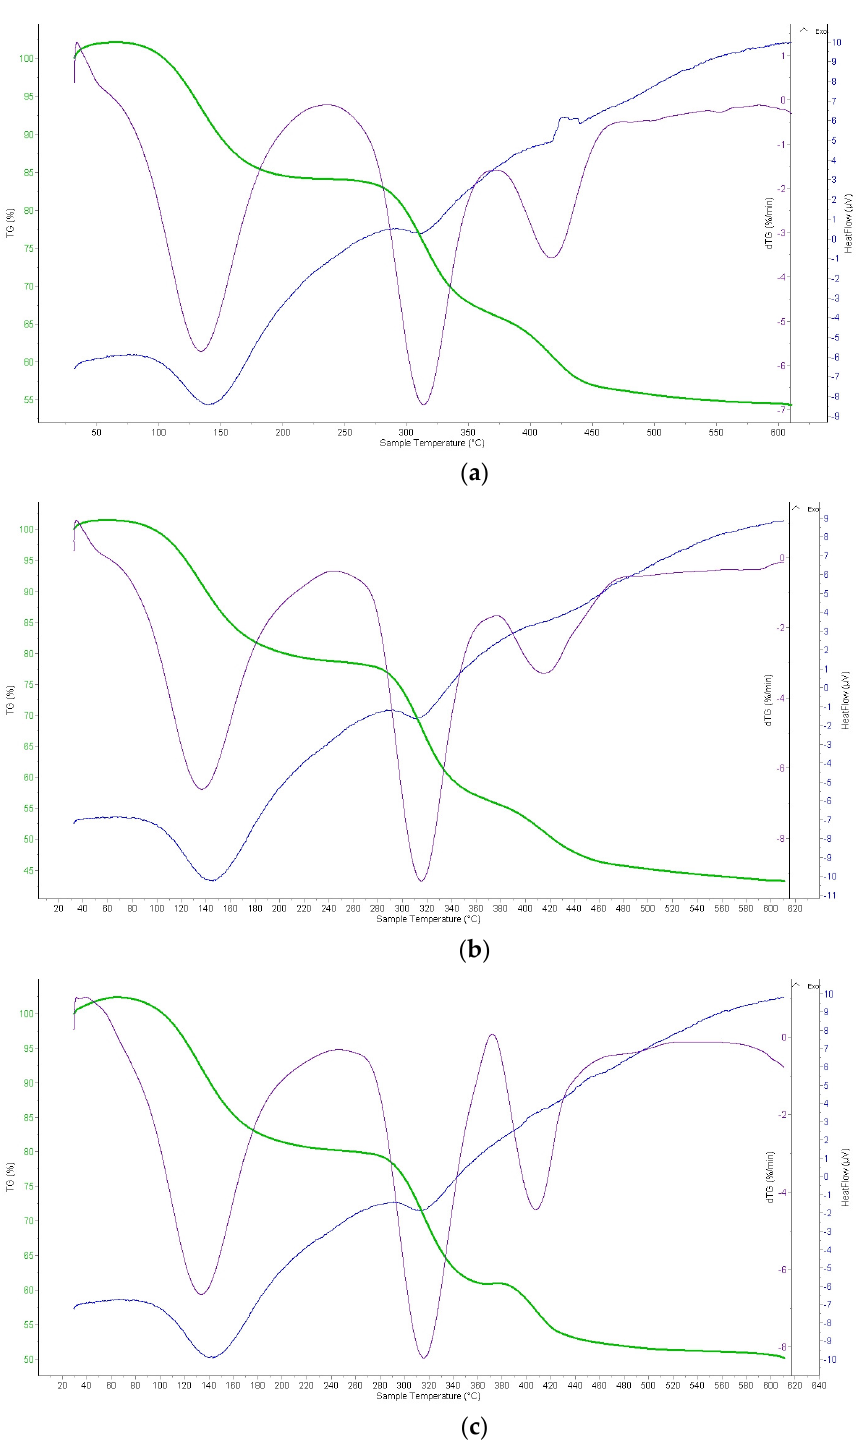
Figure 12. TGA curves of ( a ) Amberlite IR120; ( b ) Amberlite IR120 6:0; ( c ) Amberlite IR120 1:5. Figure 13 represents comparison of thermal destruction curves (mass loss (a) and rate of mass loss (b)) of individual Amberlite IR120, Amberlite IR120 from ratio 6:0 and Am- berlite IR120 from ratio 1:5. As seen from the data obtained, loss of mass of the three sam- ples of Amberlite IR120 occurs almost simultaneously up to 125 °C. Further mass loss occurs faster for Amberlite IR120 6:0 and Amberlite IR120 1:5 due to the presence of euro- pium ions in the polymer matrix—wherein the rate of mass loss for individual ion ex- changer is higher in comparison with Amberlite IR120 from the interpolymer pair due to